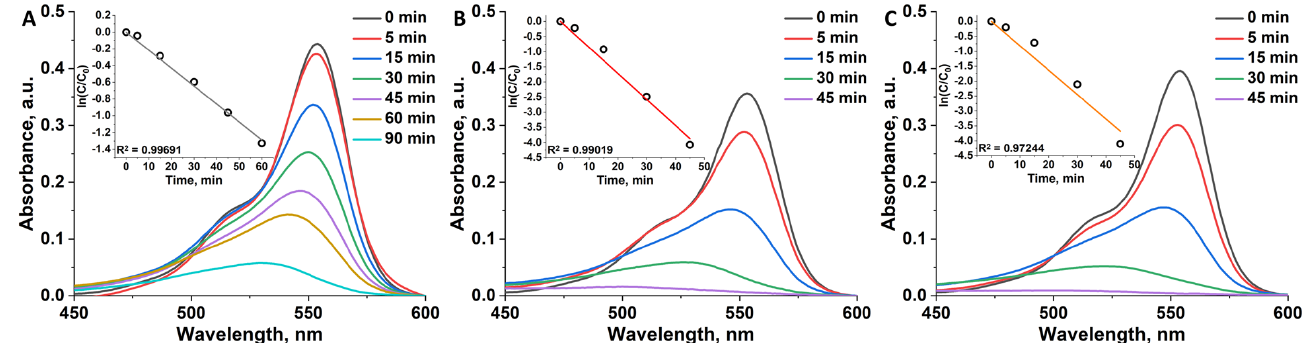
Figure 5. Absorption spectra of RhB solution before and after irradiation with UV light (λ = 365 nm, 13 mW cm − 2 ) in the presence of TiO 2 ( A ), 1 0.1 @TiO 2 ( B ), and 2 0.1 @TiO 2 ( C ) during different time intervals. Inserts are linear approximation of ln(C/C 0 ) vs. time plots used for determination of k eff . Table 2. Effective rate constants (k eff ) of RhB photodegradation under UV light (λ = 365 nm, 13 mW cm − 2 ).